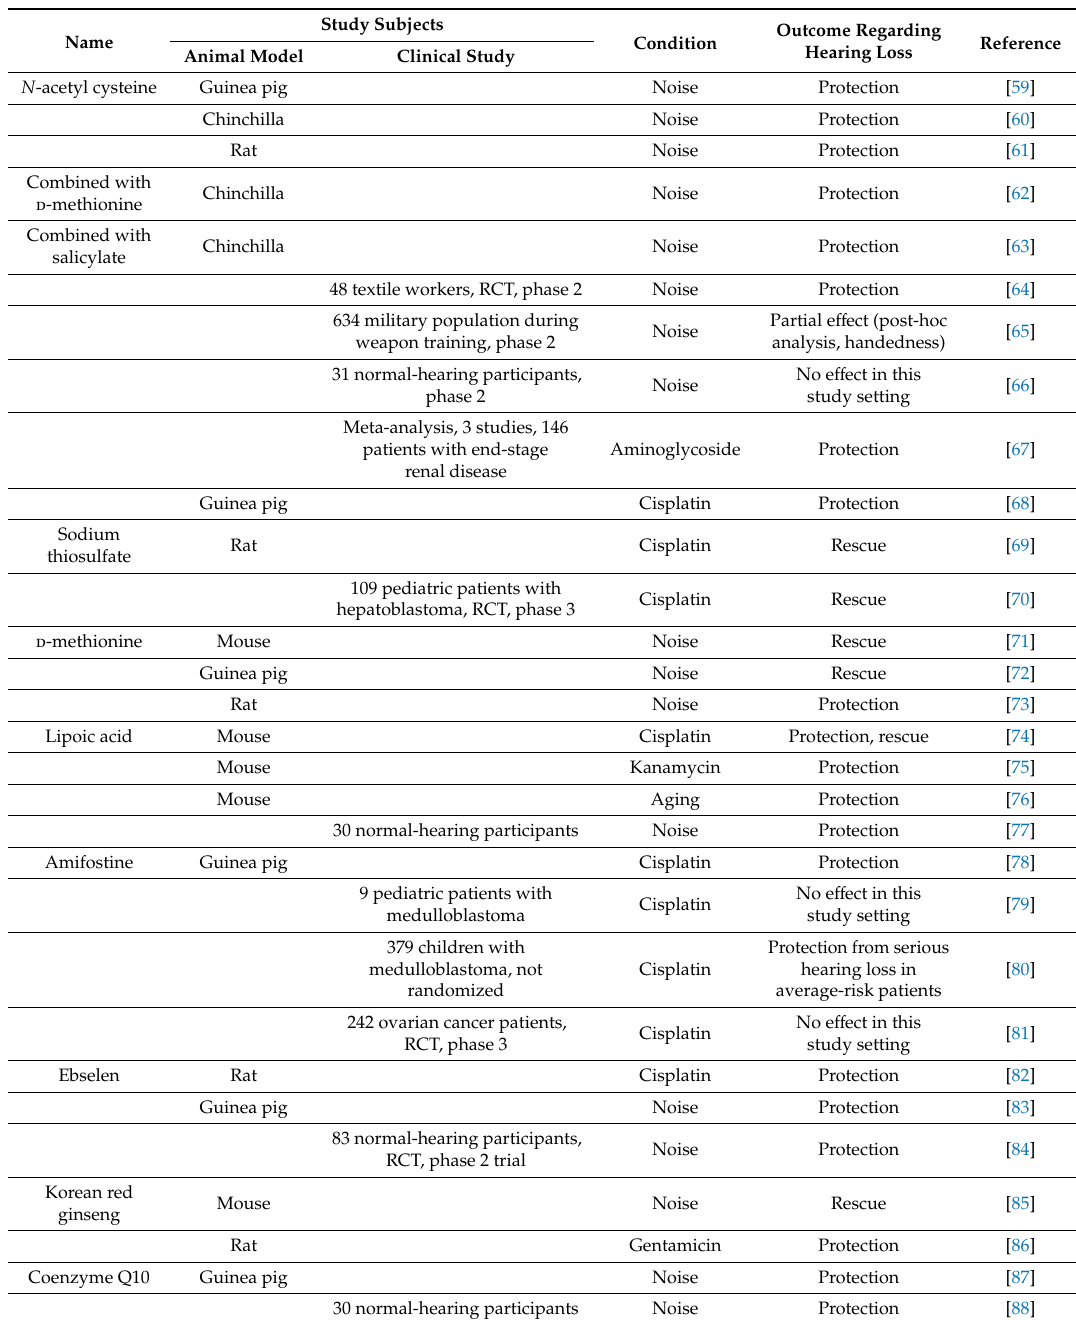
Table 1. List of antioxidants used for protection of hearing